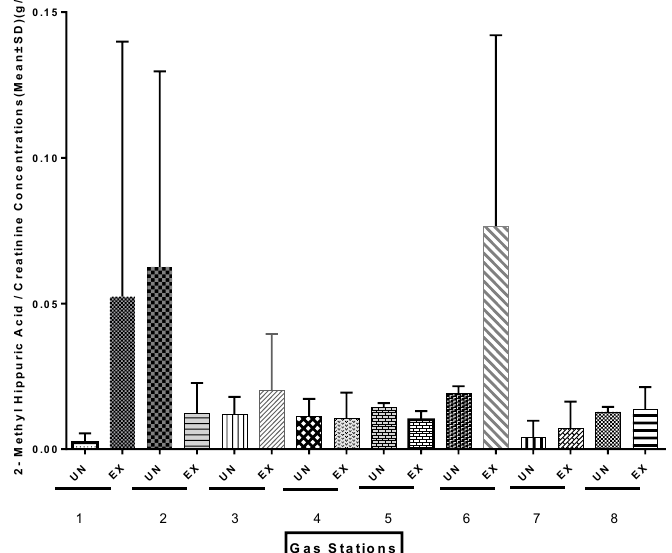
Figure 2. Mean concentrations of 2-MHA (g/g creatinine) at each gas station in the control and exposed groups regardless of the season variable Figure 2. The Mean Concentrations of 2-MHA (g/g creatinine) at Each Gas Station in the Control and Exposed Groups Regardless of the Season Variable (UN: control group; EX: exposure group) UN: Control group; EX: Exposure